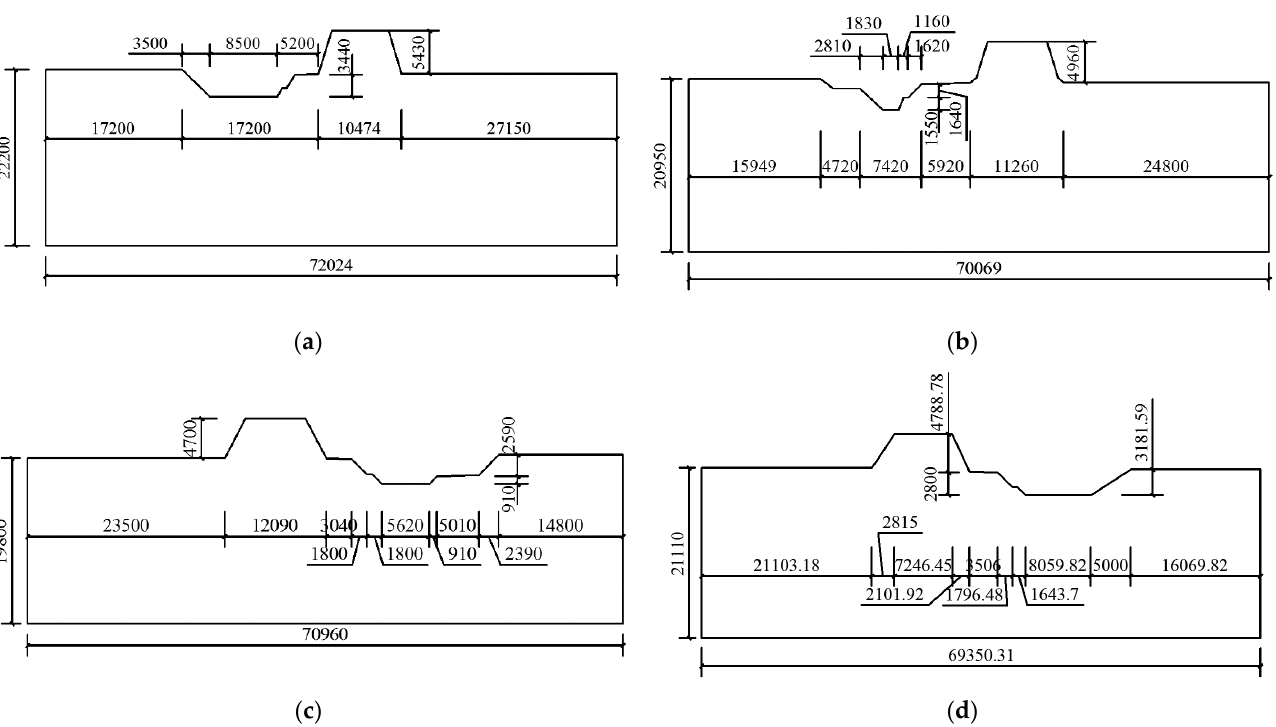
Figure 7. Location of dangerous sections. ( a ) Section B–B; ( b ) section E–E; ( c ) section H–H; ( d ) sec- tion J–J (distances are in mm).